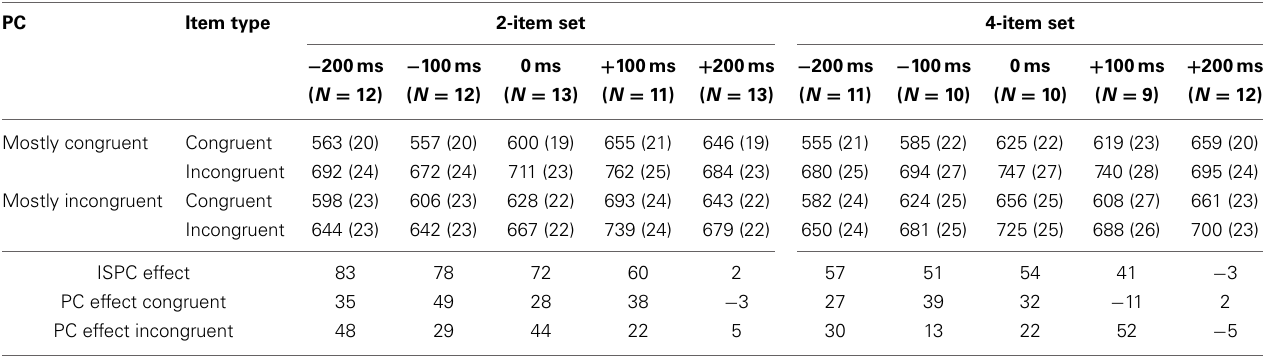
Table 5 | Mean correct RTs (ms) for the conditions of Experiment 2.